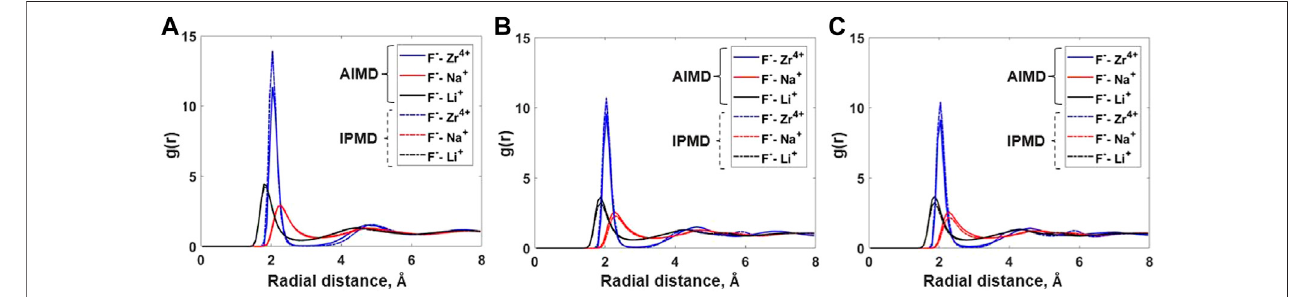
FIGURE1| Comparisonofcation – anionradialdistributionfunctionsfor (A) CompositionAat750 ° C, (B) CompositionBat727 ° C,and (C) CompositionCat700 ° C between AIMD and RIM IPMD calculations.